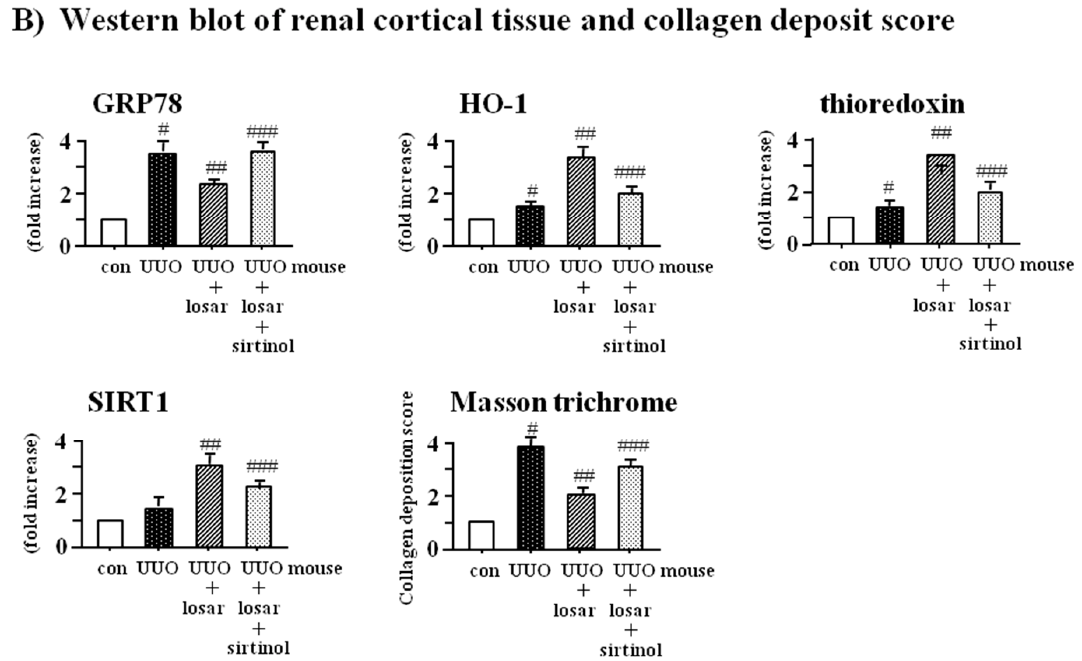
Figure 8. Reduction of renal tubular GRP78 expression and renal fibrosis by losartan through up-regulation of SIRT1 in a mouse model of unilateral ureteral obstruction. Unilateral ureteral obstruction (UUO) mouse model was induced by ligation of left ureter through flank incision. Mice were randomly divided into four groups: control mice ( n = 4), mice with UUO (UUO mouse) ( n = 4), UUO mice with losartan ( n = 4), and UUO mice with losartan plus sirtinol (SIRT1 inhibitor, 5 mg/kg i.p.) ( n = 4). Losartan (losar) was administered by gavage at 10 mg/kg/day. Immunohistochemical and Masson trichrome staining ( A ) and Western blot of renal cortical tissue and collagen deposit score ( B ) were performed. Representative microscopic scans and quantitative analysis were shown. #: p < 0.05 vs. con (control); ##: p < 0.05 vs. UUO; ###: p < 0.05 vs. UUO + losar; scale bars = 20 µm.